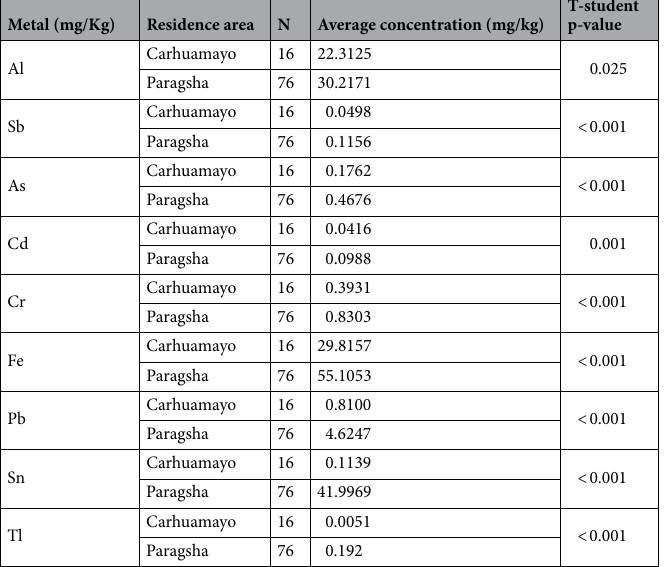
Table 4. Association between area of residence and heavy metal concentration. Carhuamayo: region unexposed to the mine; Paragsha: region exposed to the mine. N number of children.